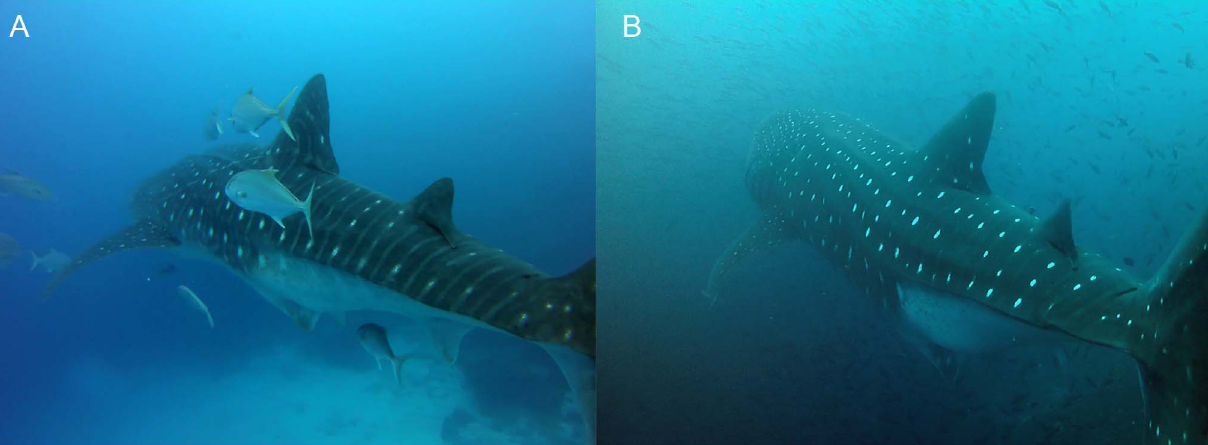
Fig. 5. Visual evidence of R. typus possible pregnancy. Image of two female whale sharks recorded at Darwin Island that displayed different signs of pregnancy (A) a 9.3 m TL female sighted on November 18 th 2013 with its belly not distended; (B) a 12 m TL female sighted on October 20 th 2012 with a clear distended belly, which is a sign of pregnancy (Ramı´rez-Macı´as et al. 2012b); (photo credit: David